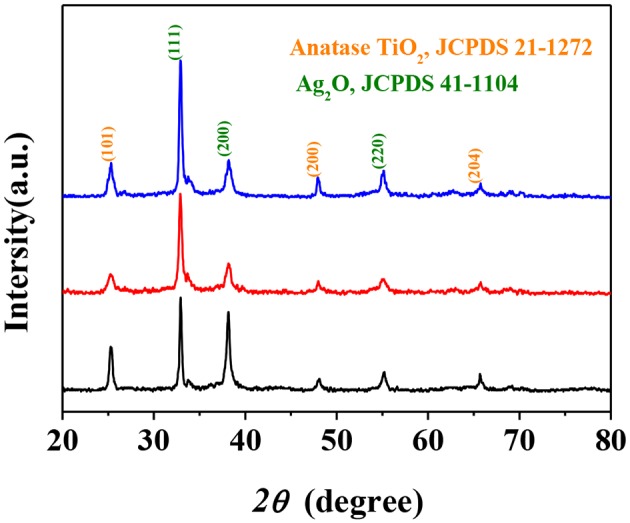
X-Ray Diffraction (XRD) patterns of Ag2O-TiO2 nanosphere (AS), Ag2O-TiO2 nanoplate (AP), and Ag2O-TiO2 nanotube (AT) samples.